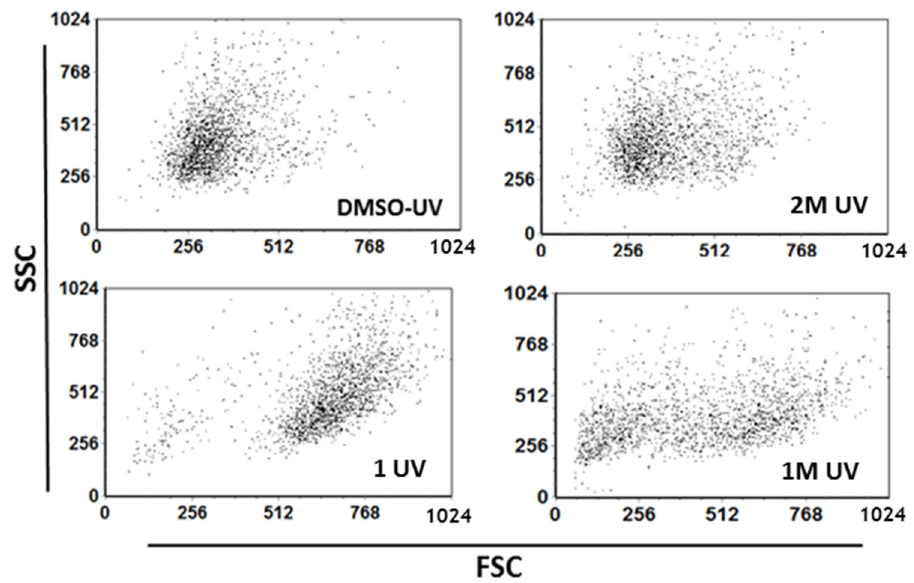
Figure 10. Exposing A549 cells treated with 10 µM 2M , 1 , or 1M to UV light induces changes in cell morphology. Cell size (FSC) and complexity (SSC) were assessed by flow cytometry. Representative data from two independent experiments are shown, both yielding similar results.